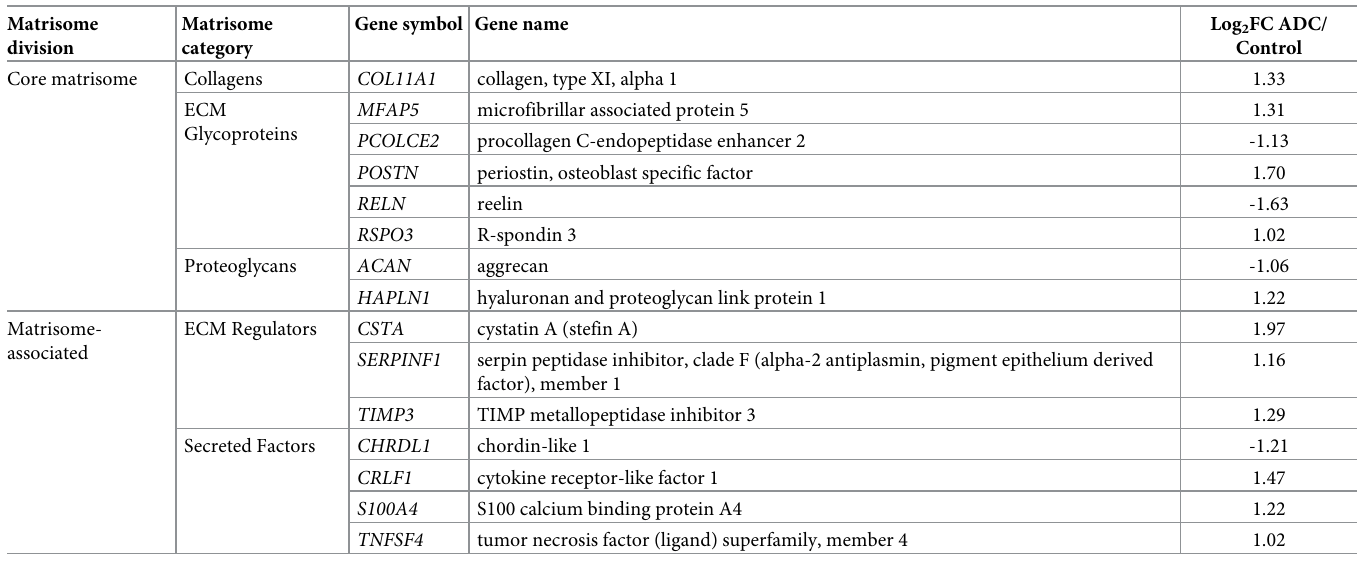
Table 3. Altered matrisome-associated genes in stromal cells derived from lung ADC compared to normal lung. Matrisome